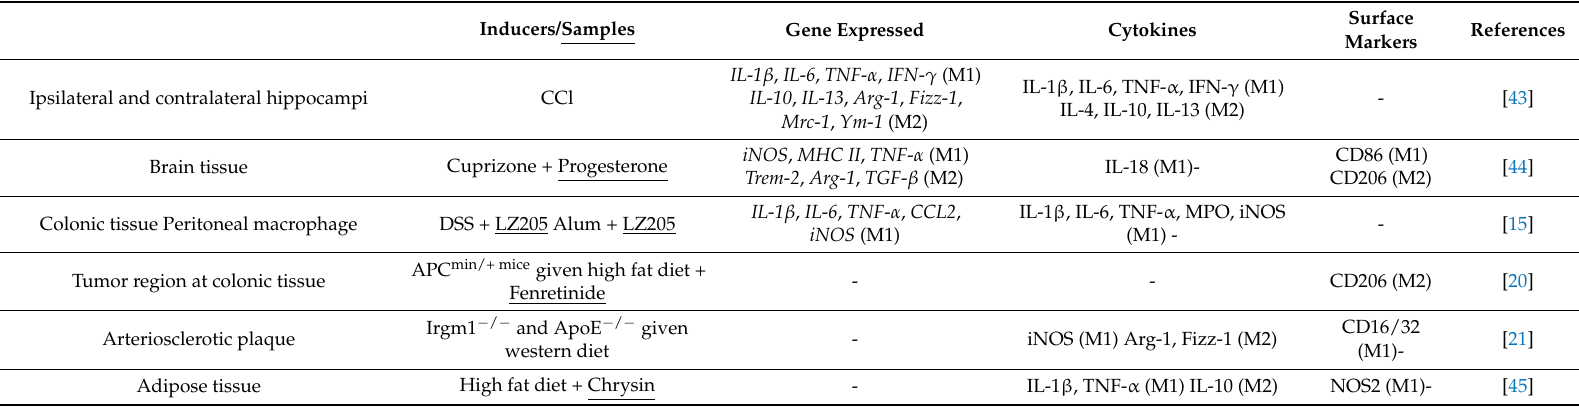
Table 2. Inflammation inducers and samples intervened in macrophages polarization in/isolated from various tissues with gene expressed, cytokines/chemokines produced and surface markers being observed and used as indicators of polarized macrophages of different states in some recent studies. (Samples intervened were underlined to differentiate with